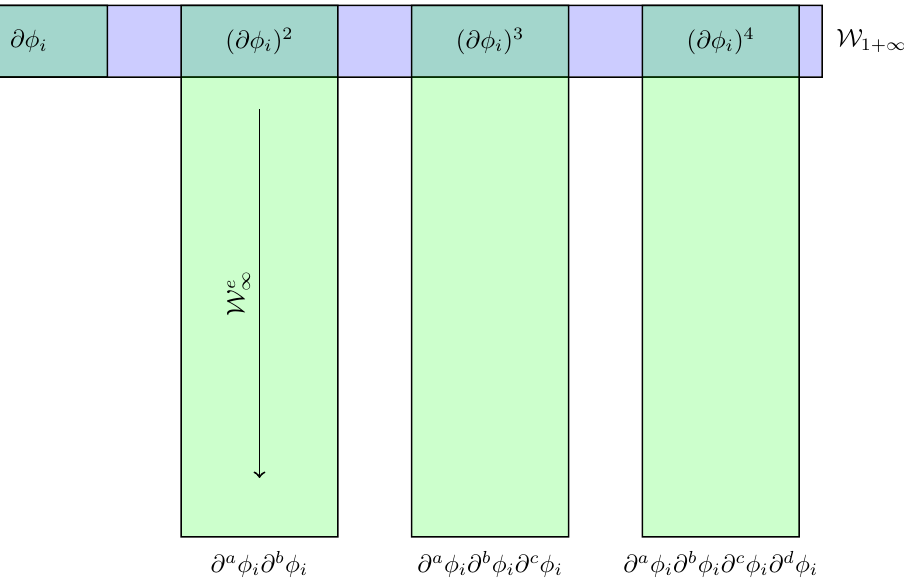
Figure 2 . The higher spin square is generated by acting by derivatives on the operators in the top row. The second column corresponds to the to its